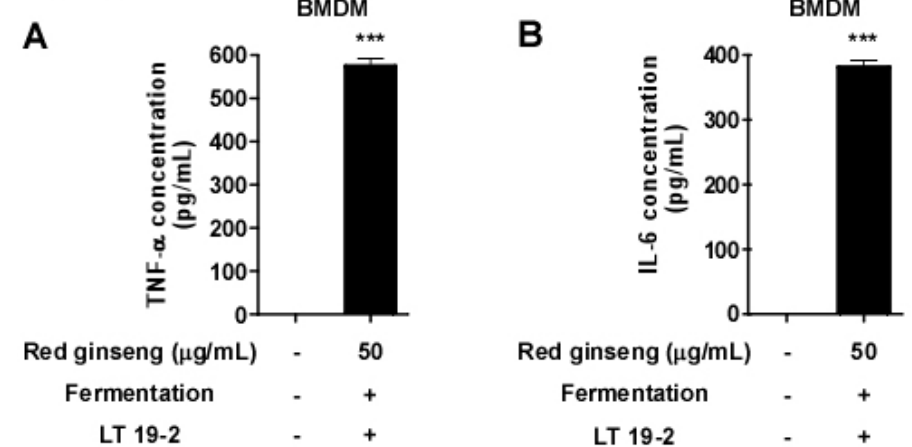
Figure 7. The effect of FRG on TNF- α and IL-6 production in bone marrow-derived macrophages (BMDMs). Primary BMDMs were isolated from mice and differentiated for six days. Media was collected for TNF- α and IL-6 analysis 24 h after FRG treatment. ( A ) TNF- α and ( B ) IL-6 levels were measured as described in the Materials and Methods section. *** p < 0.001, significant difference between FGR treated group and control ( n = 3).